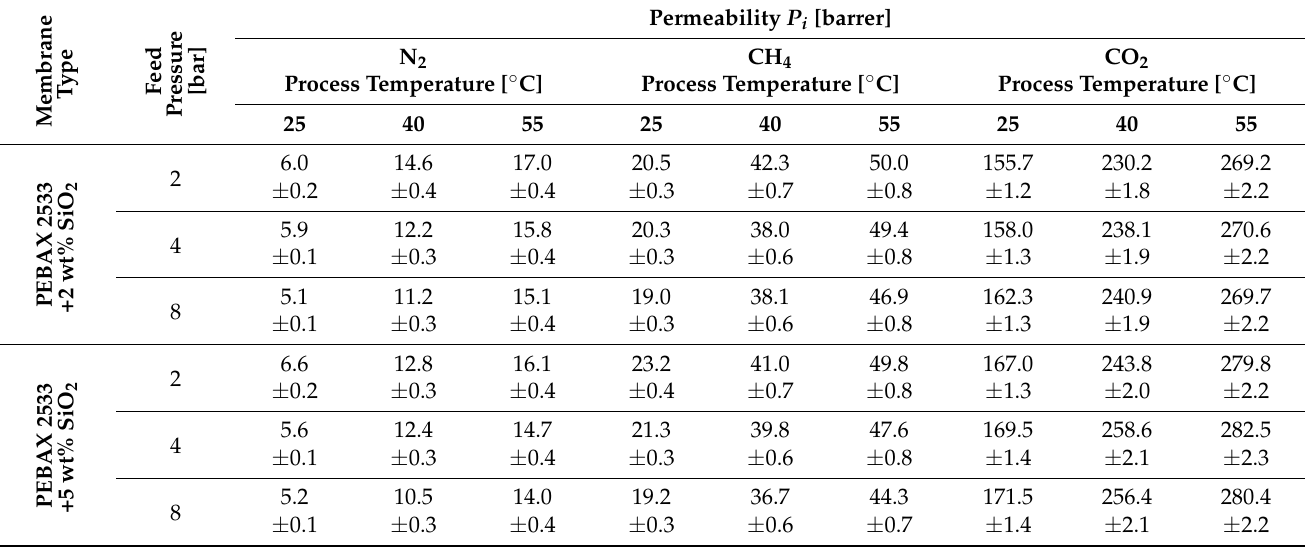
Table A2. Permeability of heterogeneous membranes containing SiO 2 to different gases measured for different feed pressure and temperature values.